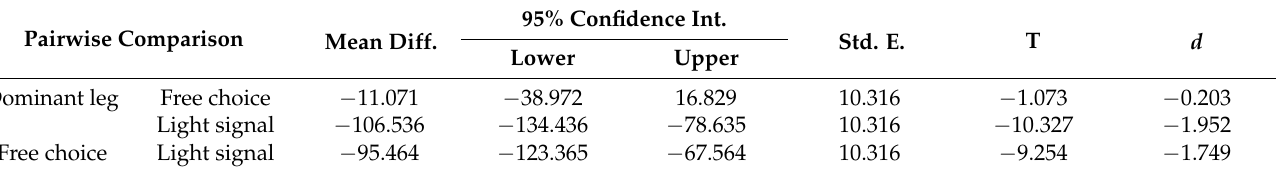
Table 3. Effect of task complexity on leg movement response